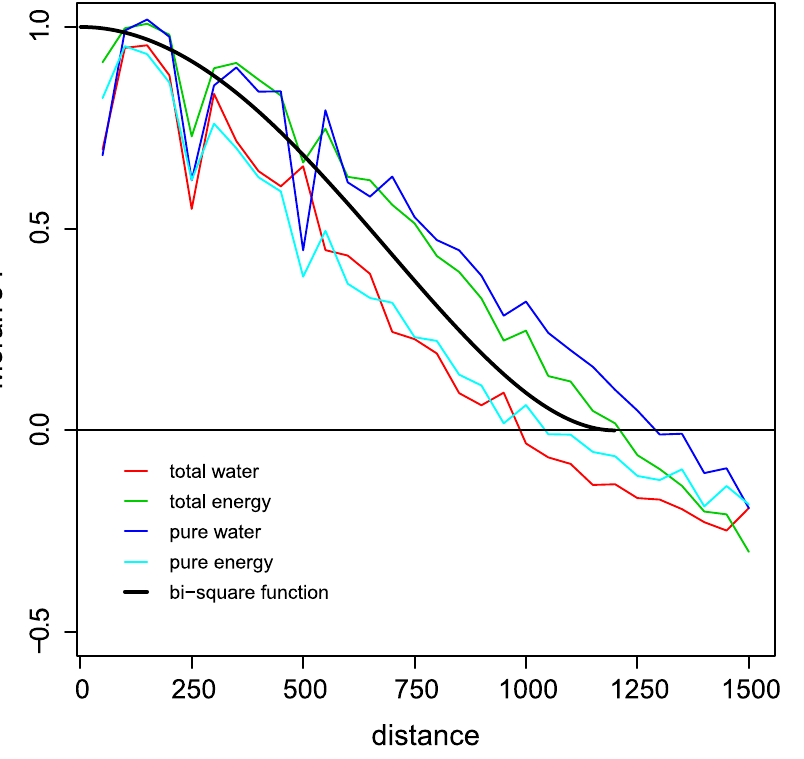
Figure 1. Inherent spatial autocorrelation of local GWR results. Moran’s I correlogram of the amount of variation in American palm species richness locally explained by water and energy in geographically weighted regression. The black line shows the kernel function of the GWR analysis for comparison, a bi-square function with a bandwidth of 1200 km. Distance in km.